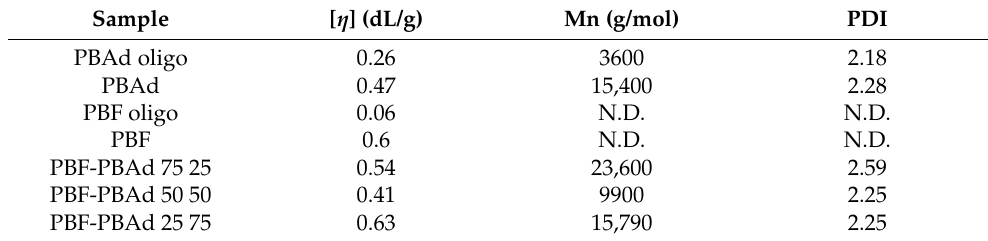
Table 1. Intrinsic viscosity values of the synthesized oligomers and polymers. Sample